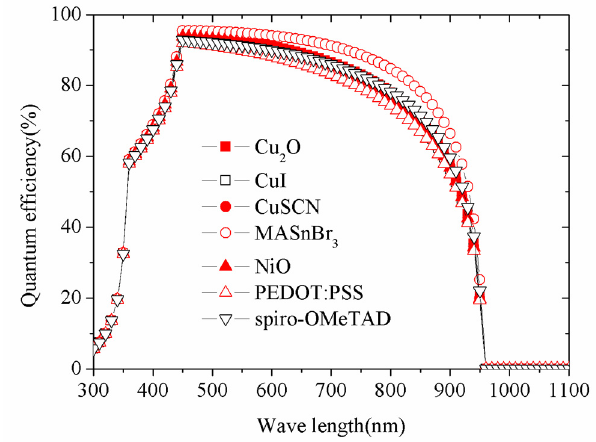
Figure 6. E ff ect of di ff erent HTL materials on QE. Figure 6. Effect of different HTL materials on QE. Figure 6. Effect of different HTL materials on QE.